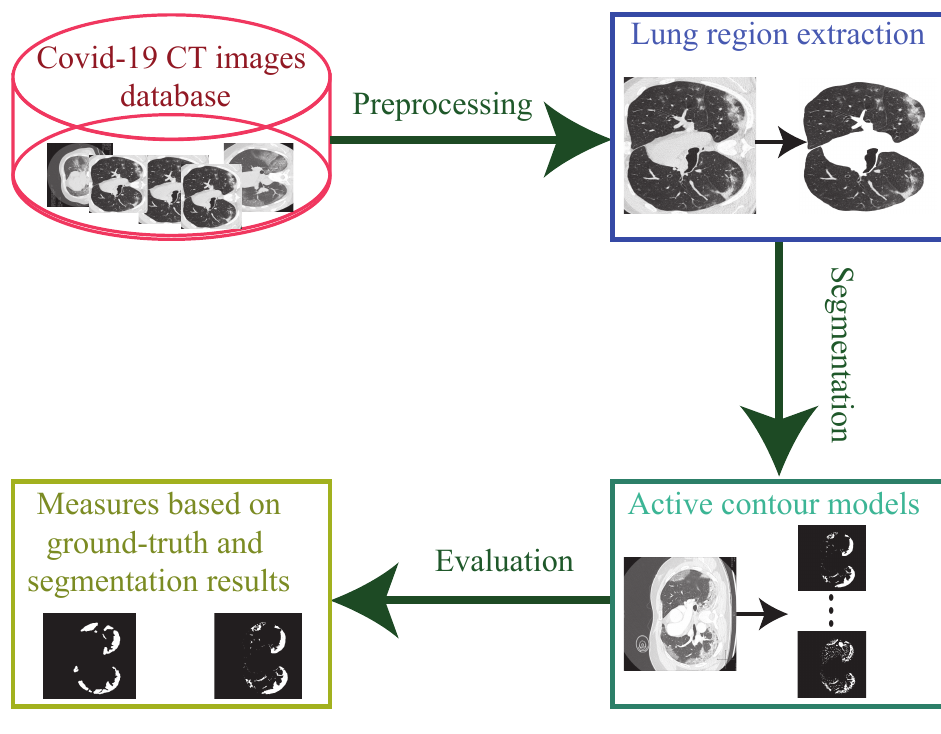
Figure 1. Overview of the proposed